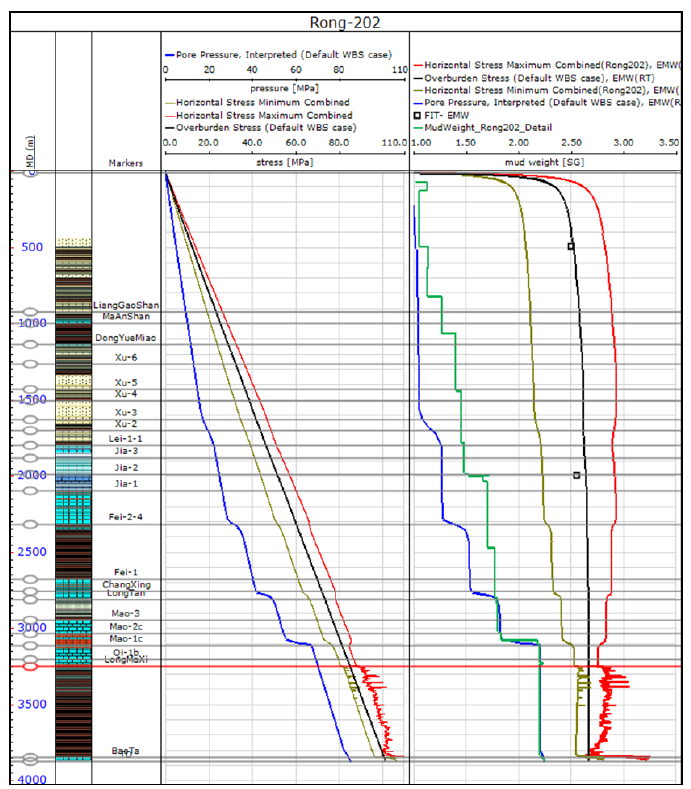
Figure 22. Final stress and pore pressure model for R202.